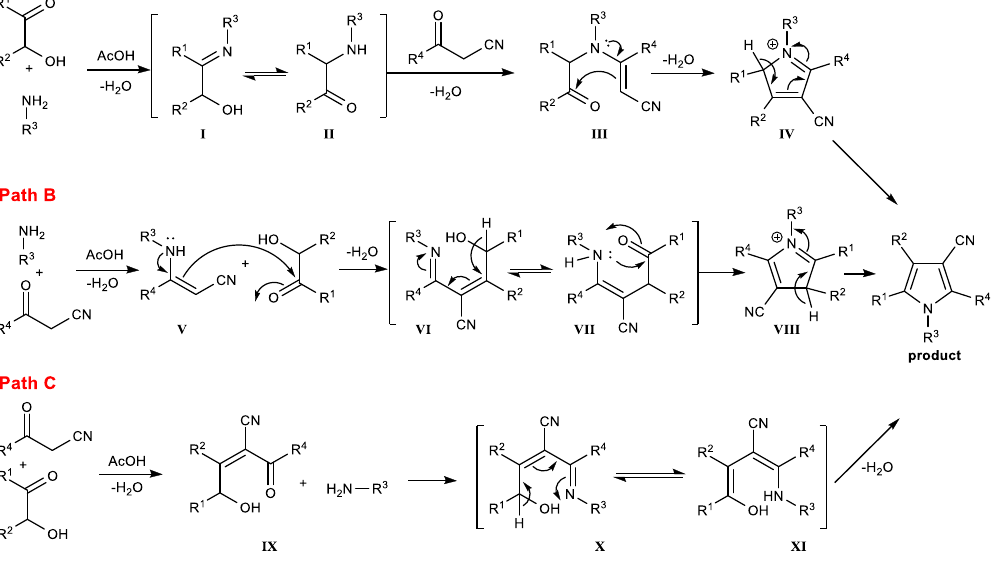
Figure 4. Proposed mechanism (paths A, B and C) for the formation of functionalized 3-cyanopyrroles. In all three pathways, the reaction proceeded with very high atom efficiency. Water was the only molecule lost during this three-component reaction.